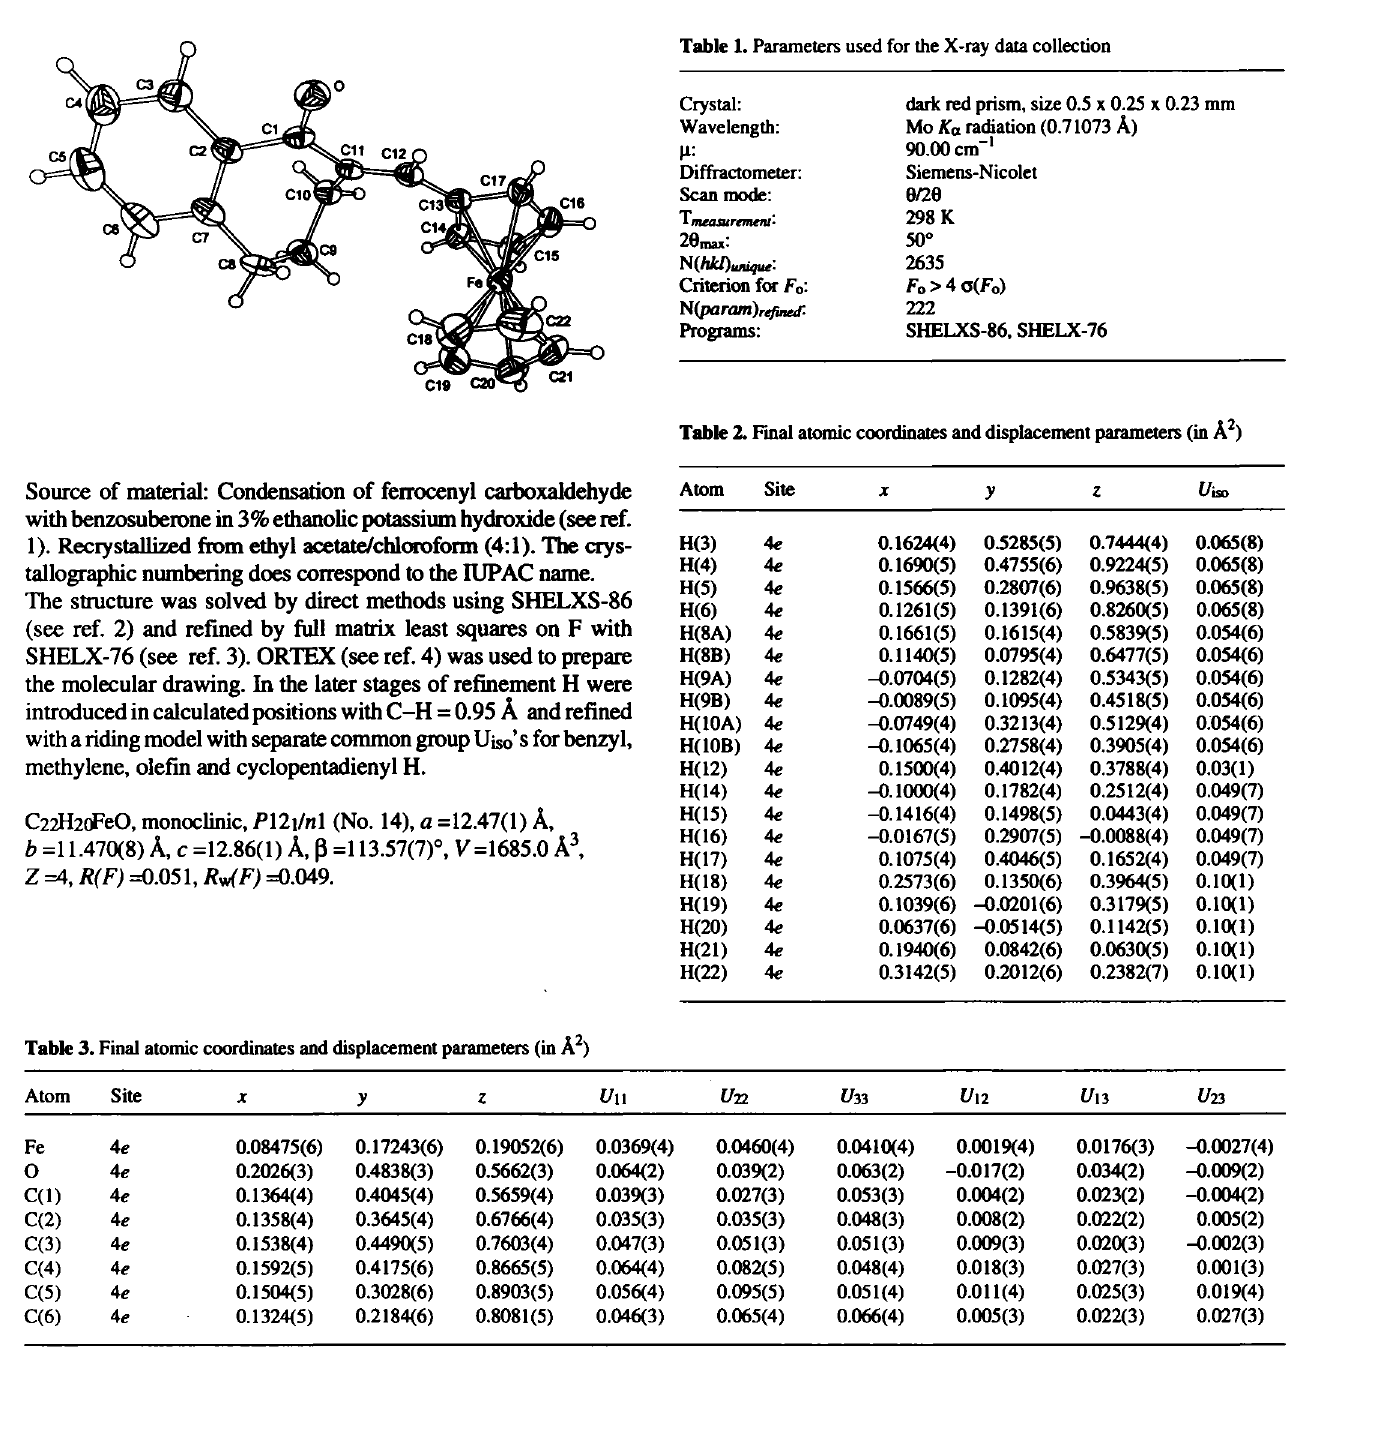
Table 1. Parameters used for the X-ray data collection